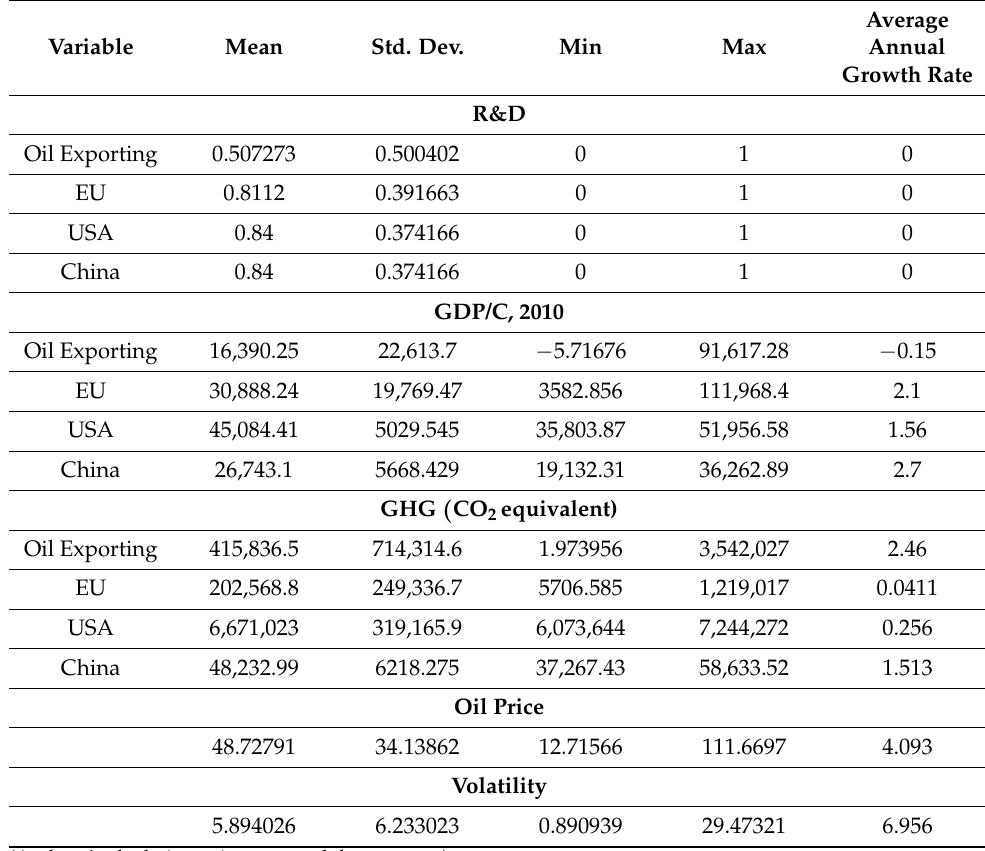
Table 1. Results of descriptive statistics.